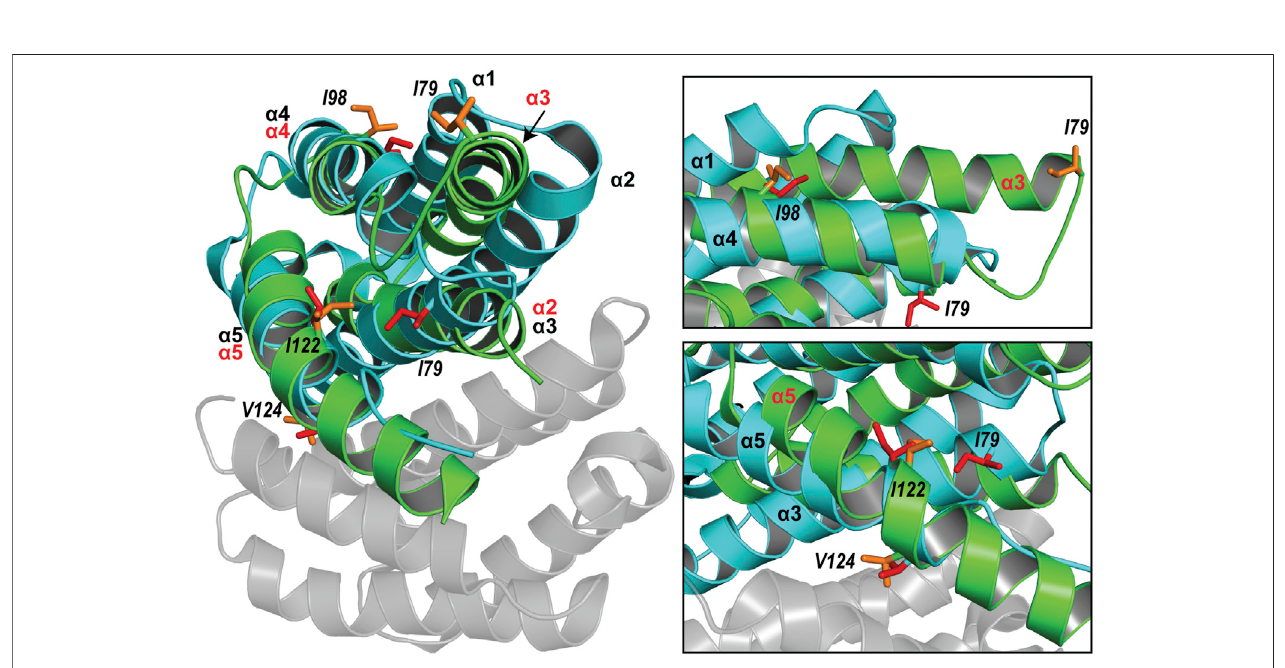
Frontiers in Molecular Biosciences |